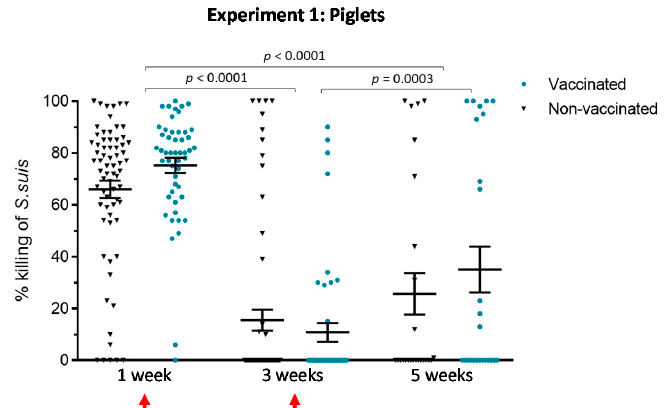
Figure 4. Experiment 1: Opsonophagocytosis killing of S. suis serotype 7 induced by serum antibodies from piglets. Blood samples were collected from randomly chosen piglets at one, three and five weeks of age. Blood samples from 50 vaccinated and 70 non-vaccinated (including the 20 placebos) at one and three weeks of age and from 25 vaccinated and 25 non-vaccinated (including the 20 placebos) at five weeks of age were tested in an opsonophagocytosis assay (OPA) to evaluate their functionality. For OPA, blood leukocytes were mixed with S. suis serotype 7 (vaccine strain) at a multiplicity of infection of 0.01. Control sera or sample sera from vaccinated piglets or non-vaccinated piglets were added to a final concentration of 40% v/v in microtubes which were incubated for 4 h. After incubation, viable bacterial counts were performed and the percentage of bacterial killing was determined. The results are expressed as percent of bacterial killing for individual sera, with horizontal bars representing mean ± SEM. Values significantly different are shown in the graph with corresponding p value. Arrows indicate first and second vaccination doses.